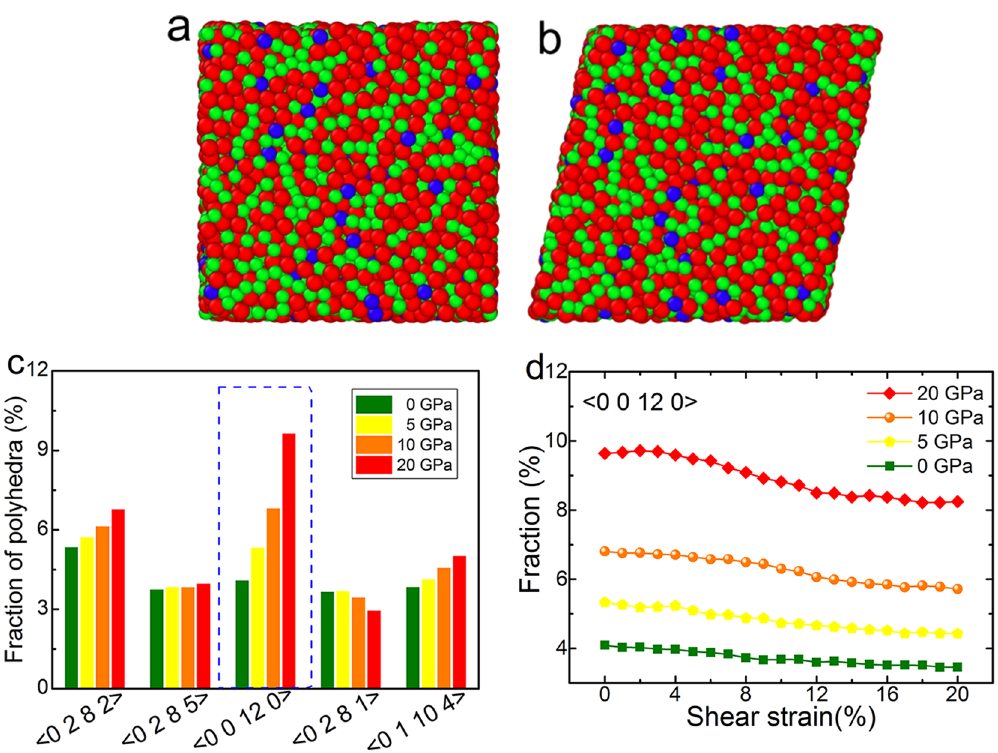
Figure 7. The examination on atomic structure of Zr 50 Cu 44 Al 6 MG via MD simulations. The illustrations of ( a ) as-prepared and ( b ) 20% shear-strained atomic configurations in the simulation box with a size of about 52 × 52 × 52 Å 3 . ( c ) The fraction of Voronoi polyhedra of the five most common atom motifs in the as-prepared samples. ( d ) The fraction of icosahedron with a Voronoi index < 0 0 12 0 > varies with the increasing shear